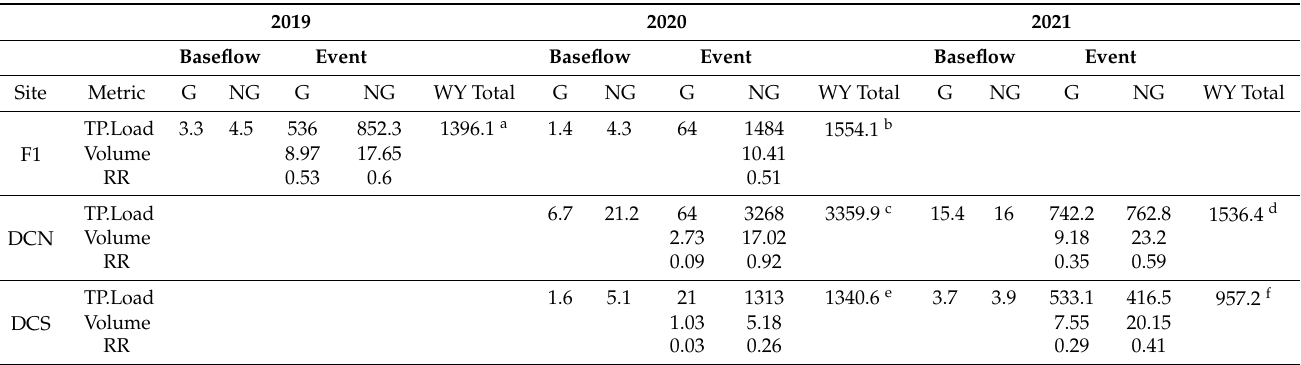
Table 2. WY-annual estimates of TD TP export (g/ha). Volume is mean event volume (mm), RR is mean event runoff ratio, G is growing season, and NG is a non-growing